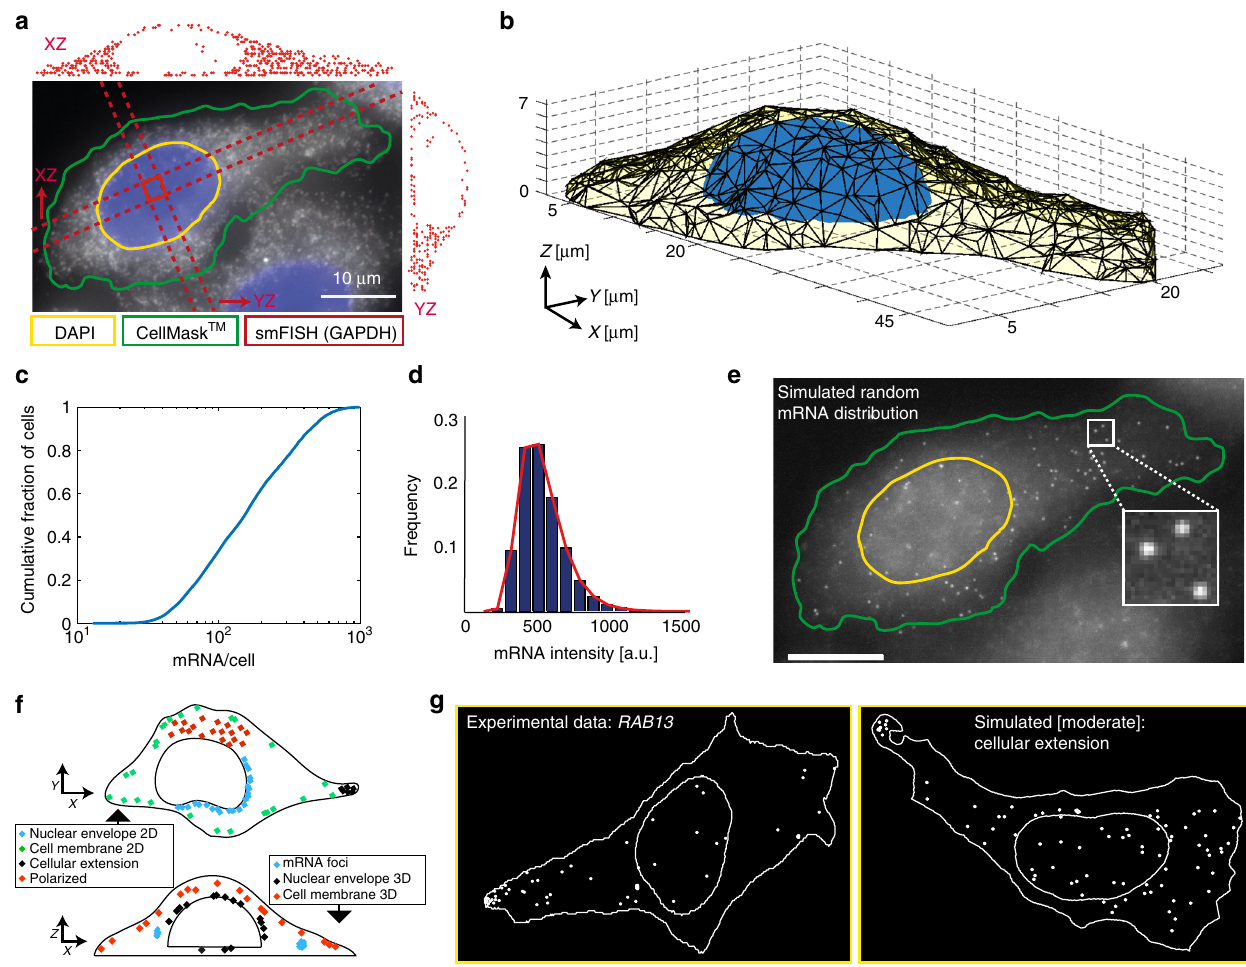
Fig. 1 Simulation of smFISH images. a smFISH experiment against GAPDH (probes labeled with Cy5) in HeLa cells shown as a maximum intensity projection along Z (MIP). Cell segmentation (green) was performed with CellMask TM , nuclear segmentation (yellow) with DAPI signal. Projections of detected GAPDH mRNAs located between the dashed lines are displayed as indicated by the arrows as side panels. b Final 3D polygon of a cell (yellow) and its nucleus (blue). c Cumulative histogram of pooled expression level. d mRNA intensity distribution extracted from experimental data ( KIF1C mRNA). Histogram is fi tted with a skewed normal distribution (red). e Example of a simulated cell with random mRNA localization shown as a MIP. Outline of cell and nucleus in green and yellow, respectively. Scale bars 10 μ m. f Cartoon illustrating the simulated seven non-random localization patterns. g Outlines of a cell and nucleus with mRNA positions of the pattern cell extension: experimental data ( RAB13 mRNA) (left), simulated data with low mRNA density